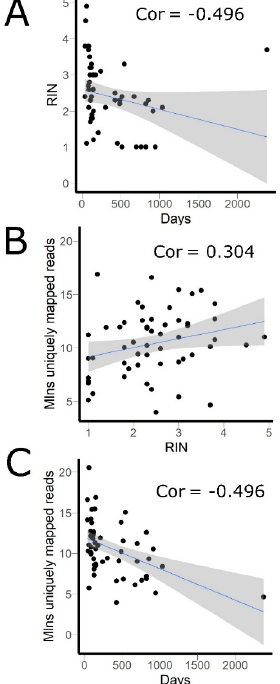
Figure 1. Effect of time interval between paraffinization and analysis (in days) on the quality of the sample. ( A ) RIN vs. time between paraffinization and analysis (Days): Spearman’s rho = − 0.496 ( p -value = 0.00012). ( B ) RIN vs. number of uniquely mapped reads per sample: Spearman’s rho = 0.304 ( p -value = 0.022). ( C ) Time between paraffinization and analysis (Days) vs. number of uniquely mapped reads per sample: Spearman’s rho = − 0.496 ( p -value = 0.0001). Grey zone indicates 95% confidence interval for the trendlines. RIN—RNA integrity number, mln—million, cor—correlation coefficient.